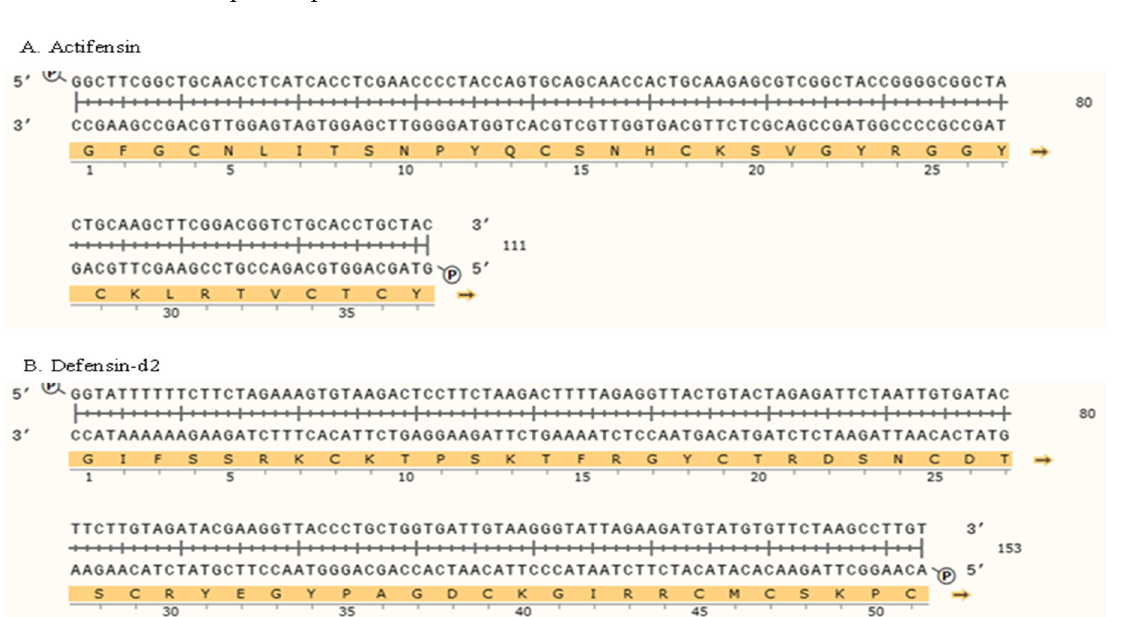
Table 1. In silico characterization of the peptides .